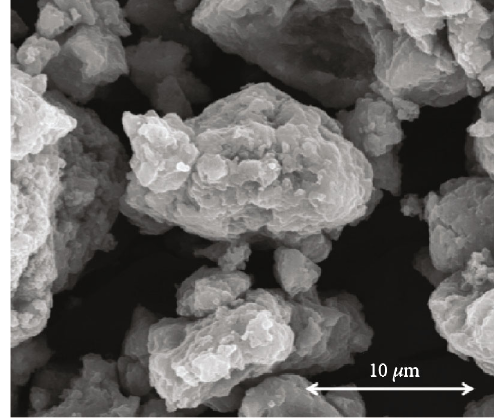
Figure 4: SEM image of the 10-UA-Tb(III) complex. Figure 4. The result showed that the 10-UA-Tb(III) complex had a rough rock structure with a size belonging in the microscopic regime. Its edge line was clear. There was an of large particles.